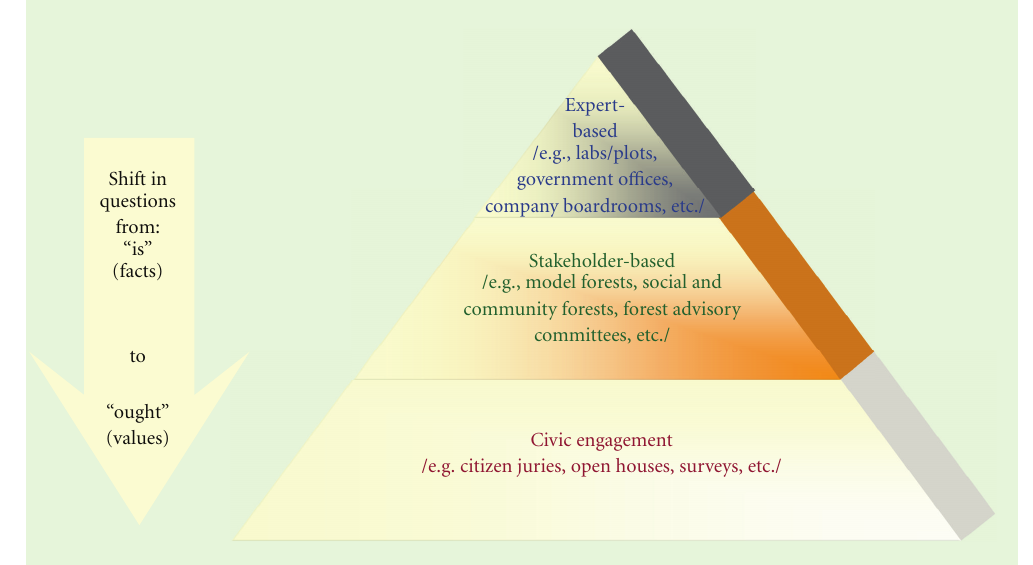
Figure 1: Three Models of SFM